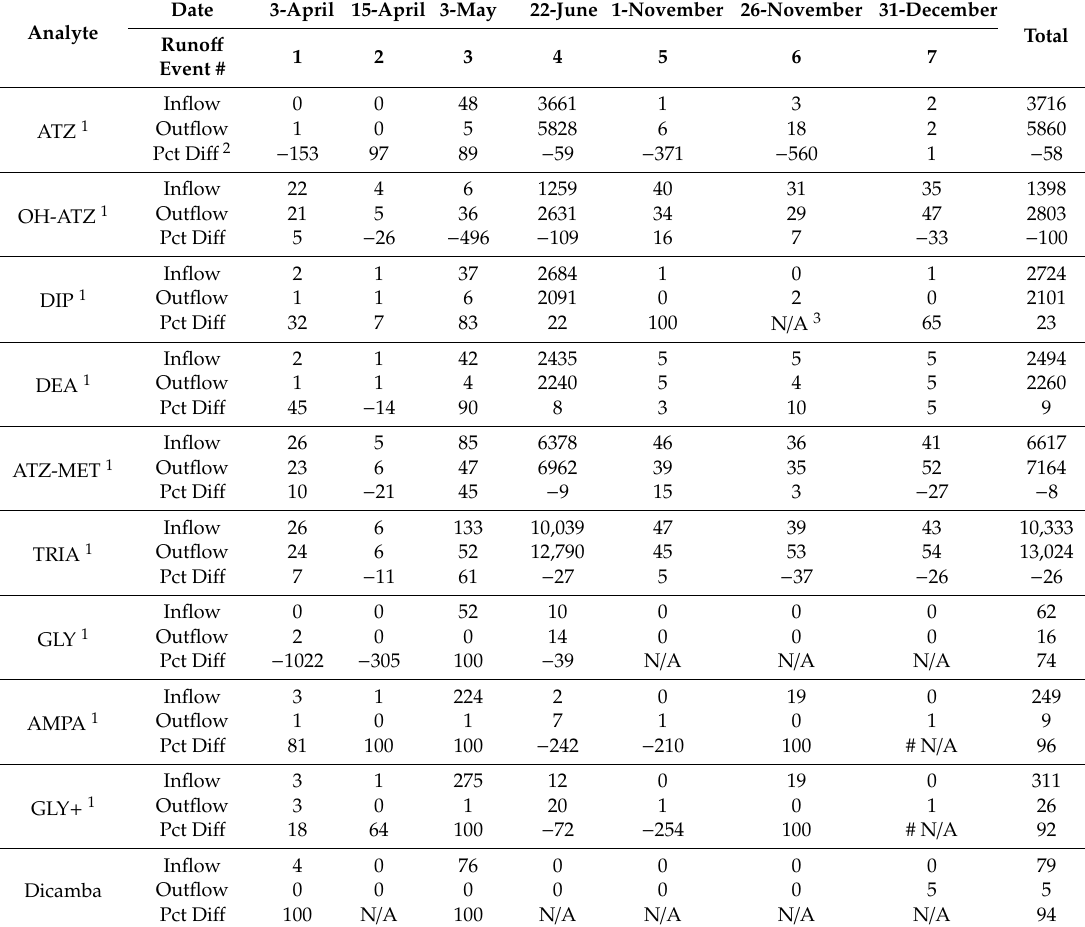
Table 6. Event and cumulative loads of several herbicides and their respective metabolites (in mg) in the inflow and outflow of the blind